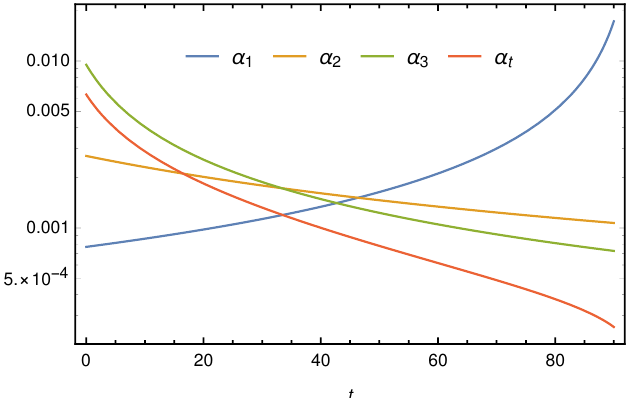
Figure 2 . Running of the gauge couplings (cid:11) i and Yukawa (cid:11) t for the SM in the 321 approximation scheme. On the horizontal axis t = ln ( (cid:22)=M Z ). Just above t ’ 40 the three gauge couplings come close together. At larger values of t , (cid:11) begins its ascent towards the Landau pole. 1 (i.e., the number of fermions that enters into the 1-loop coe(cid:14)cient of the gauge (cid:12) -functions counts all the quarks and